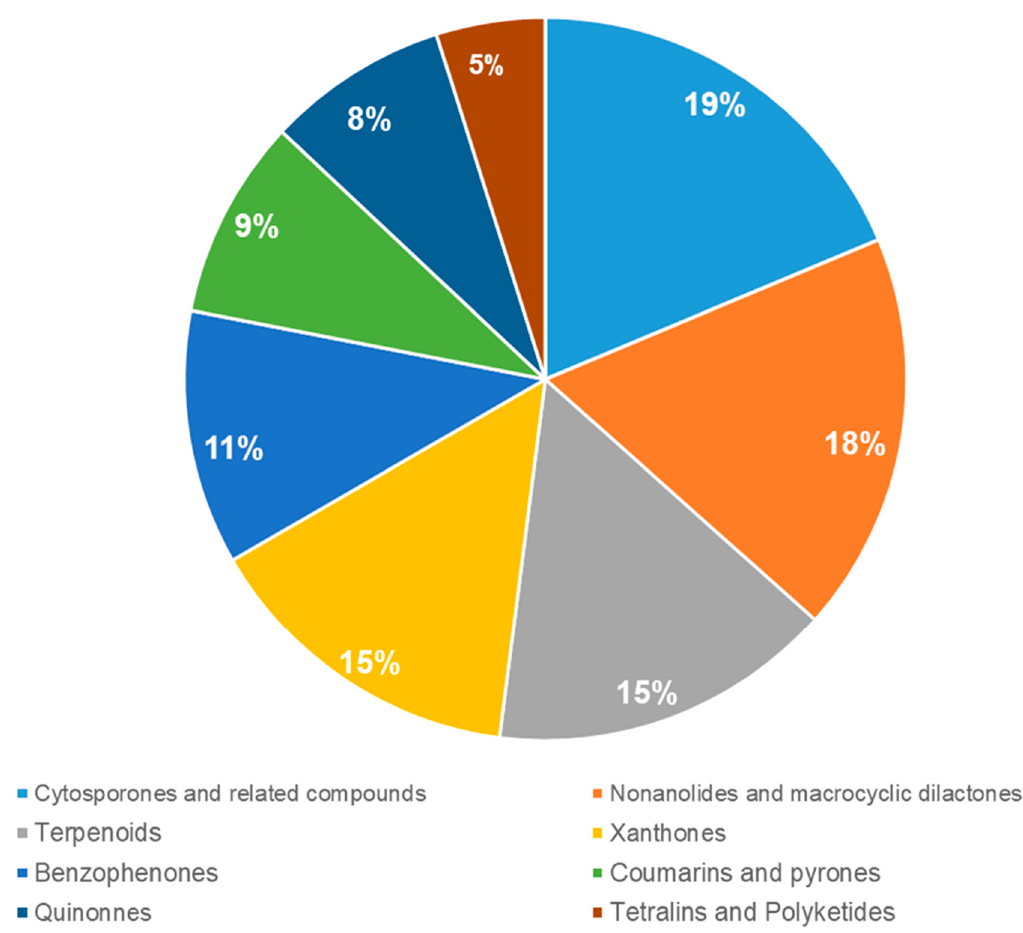
Figure 1. The distribution of isolated compounds of the genus Cytospora .